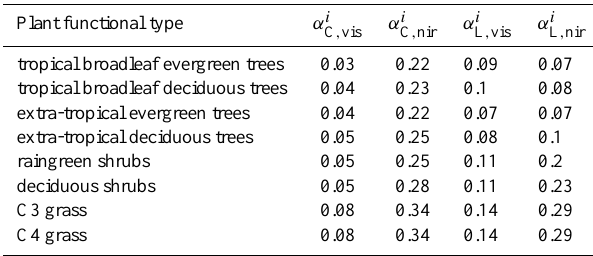
Table 1. Albedo values used in the dynamic albedo scheme. Plant functional